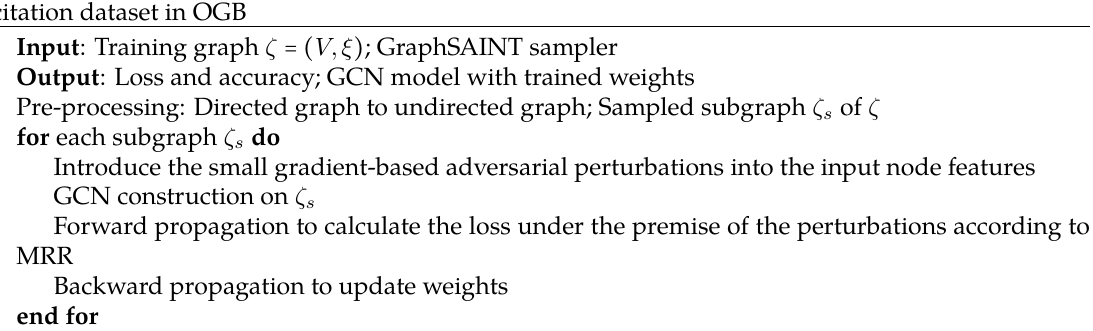
Algorithm 2 The improved GraphSAINT during training with a GNN trick named FLAG on the citation dataset in